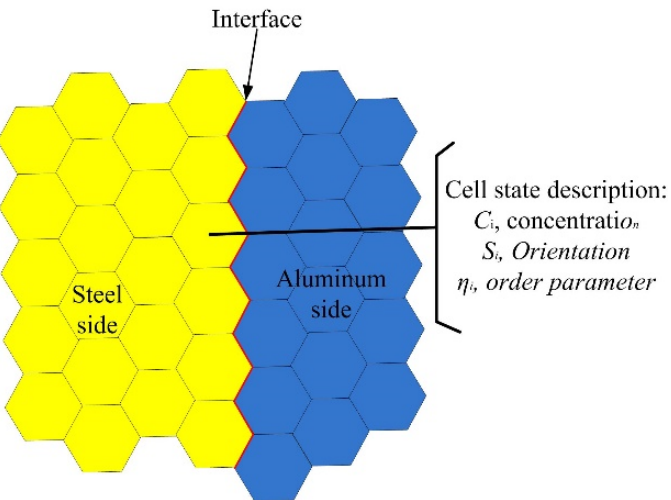
Figure 4. Schematic diagram of two-dimensional lattices.